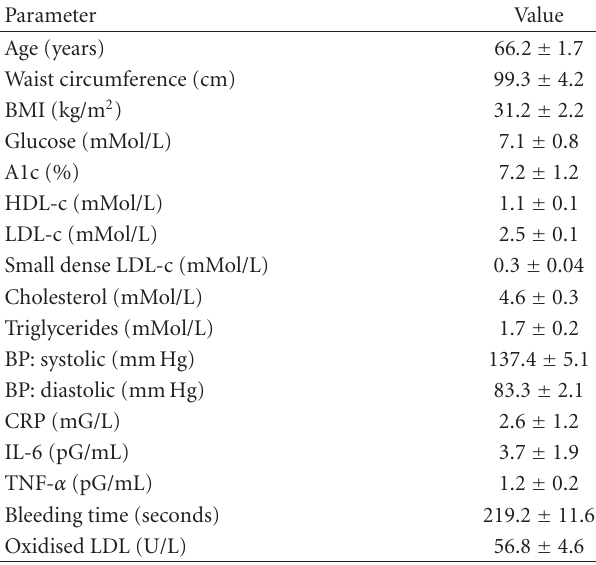
Table 1: Patient characteristics upon